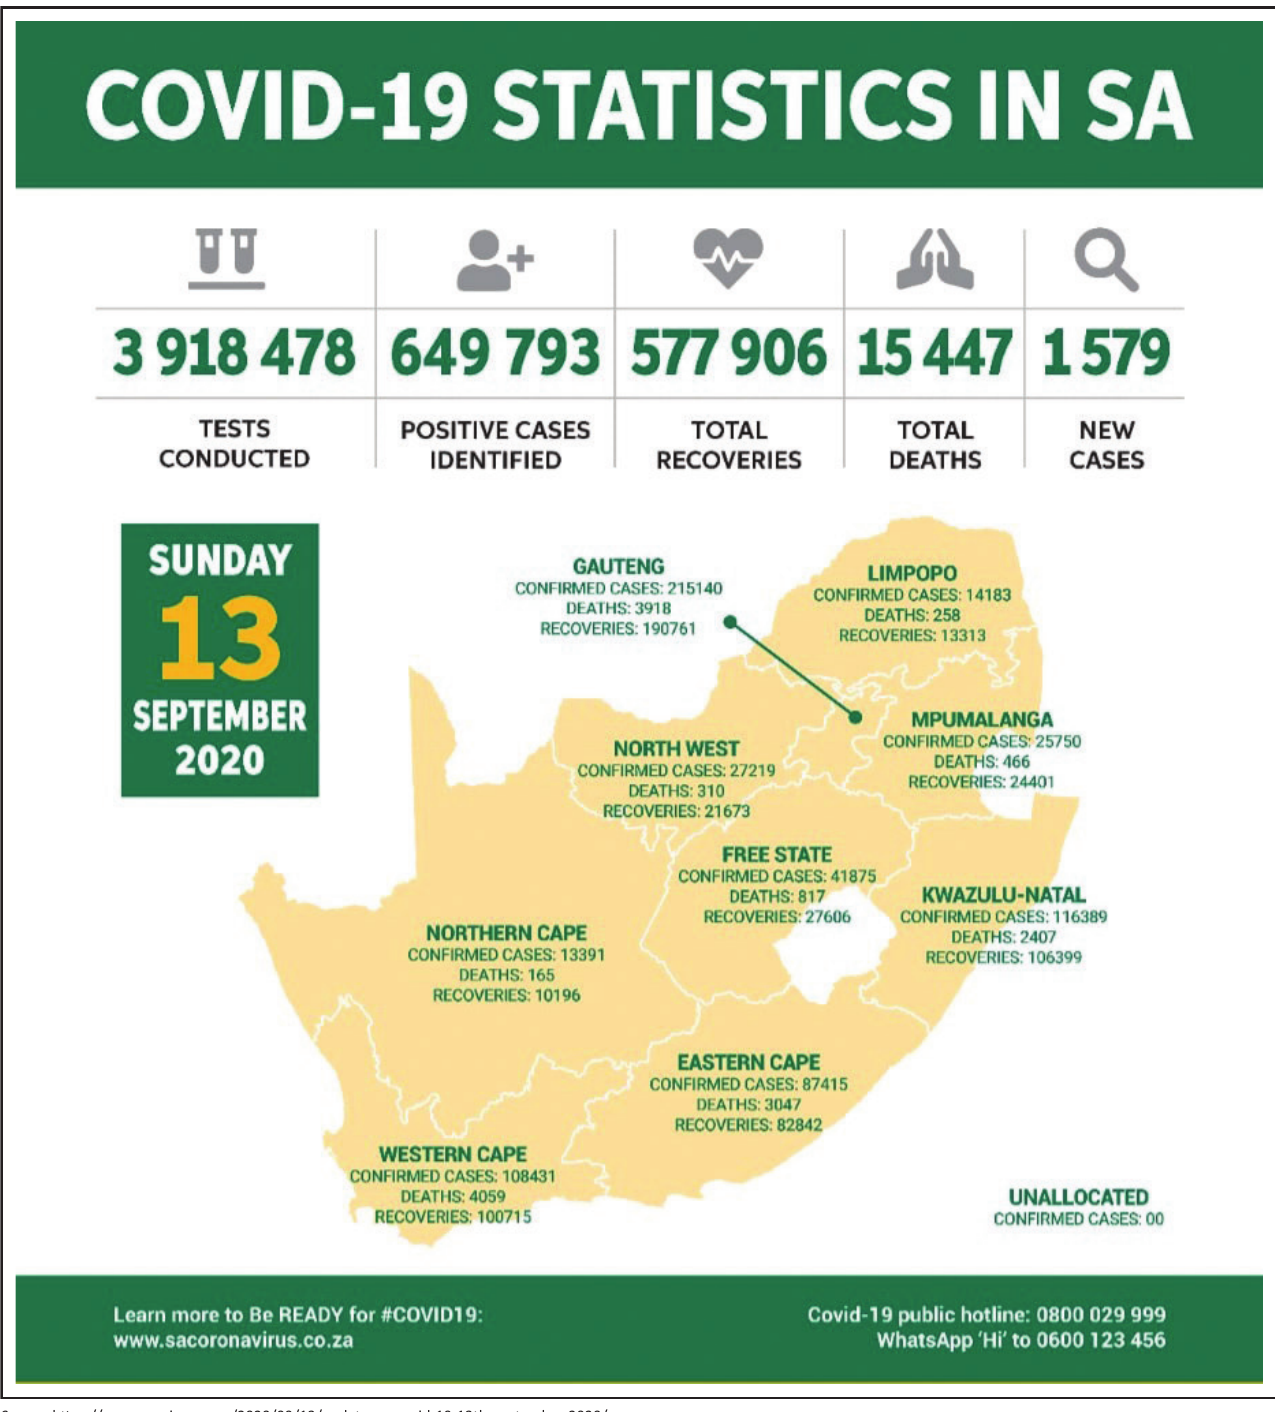
FIGURE 2-A1: COVID-19 statistics as of 13 September